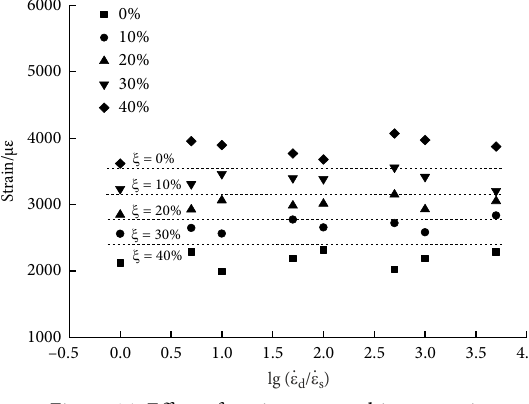
Figure 14. Effect of strain rate on ultimate strain